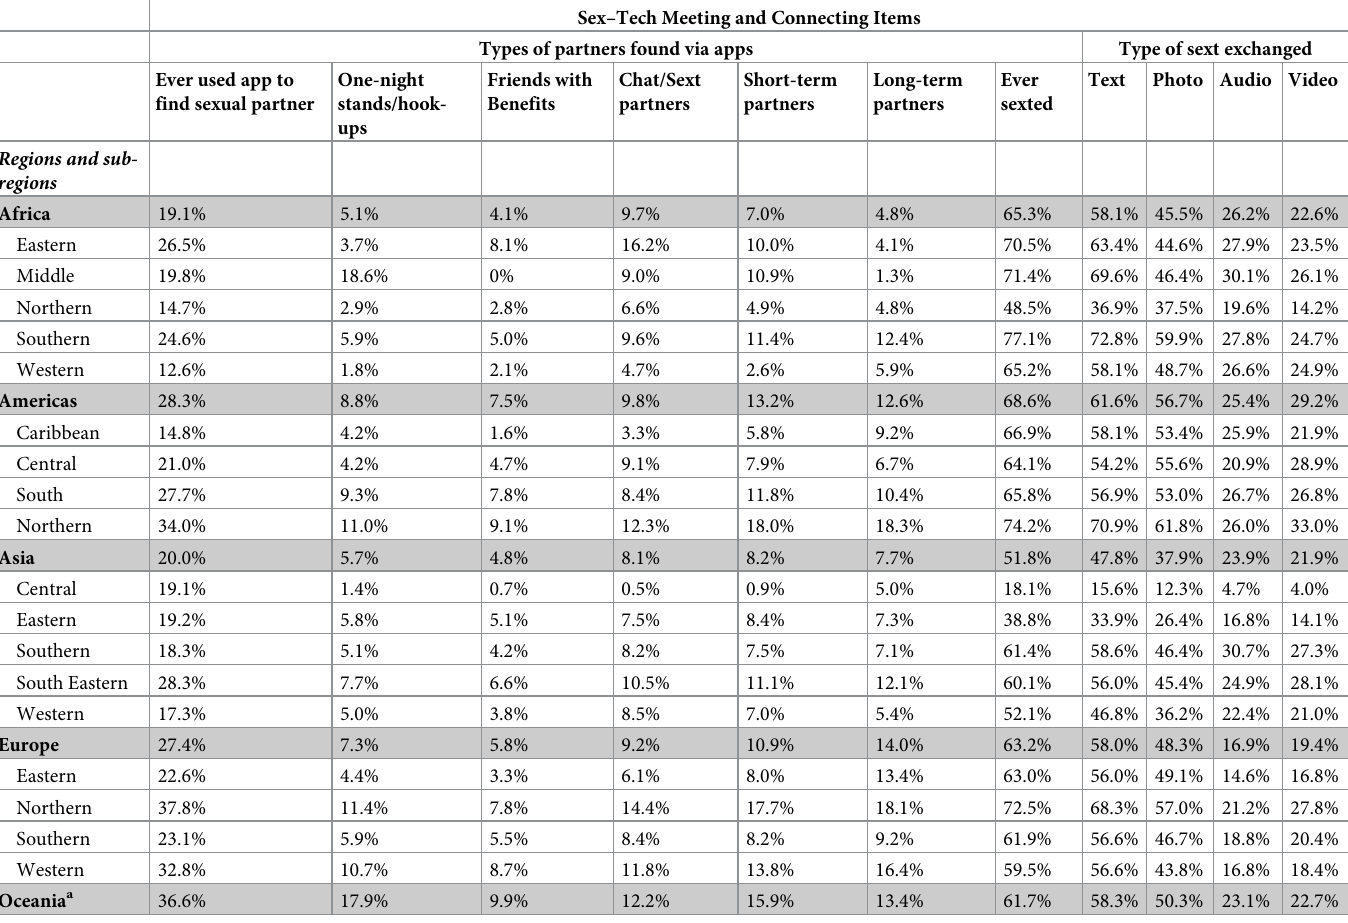
Table 2. Frequencies of those selecting “yes” for all items related to meeting and connecting, by UN-designated regions and sub-regions.